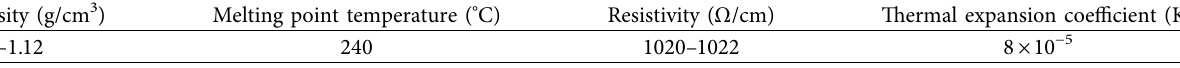
Table 3: Relevant material parameters of EPS.